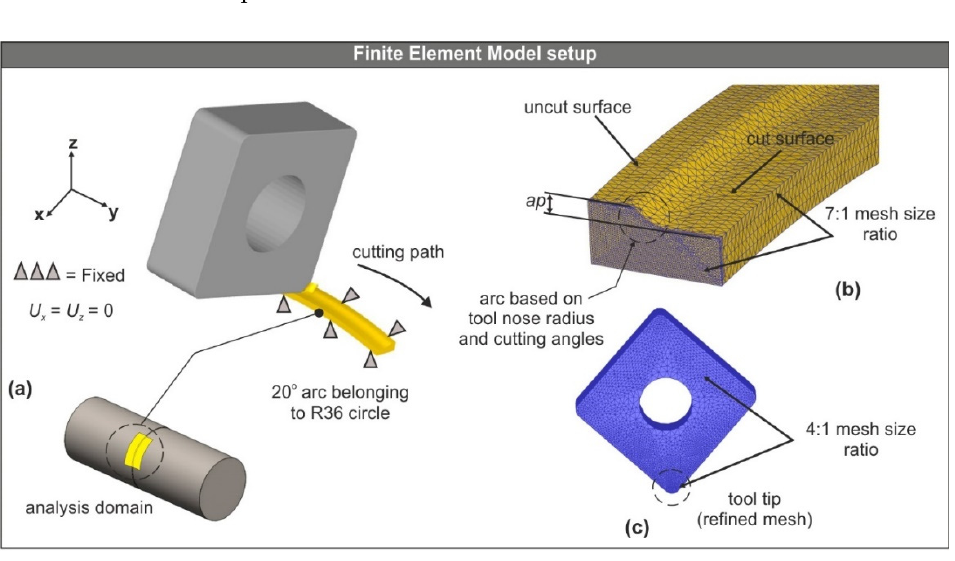
Figure 2. ( a ) The FE model setup, ( b ) the under analysis workpiece and ( c ) the meshed